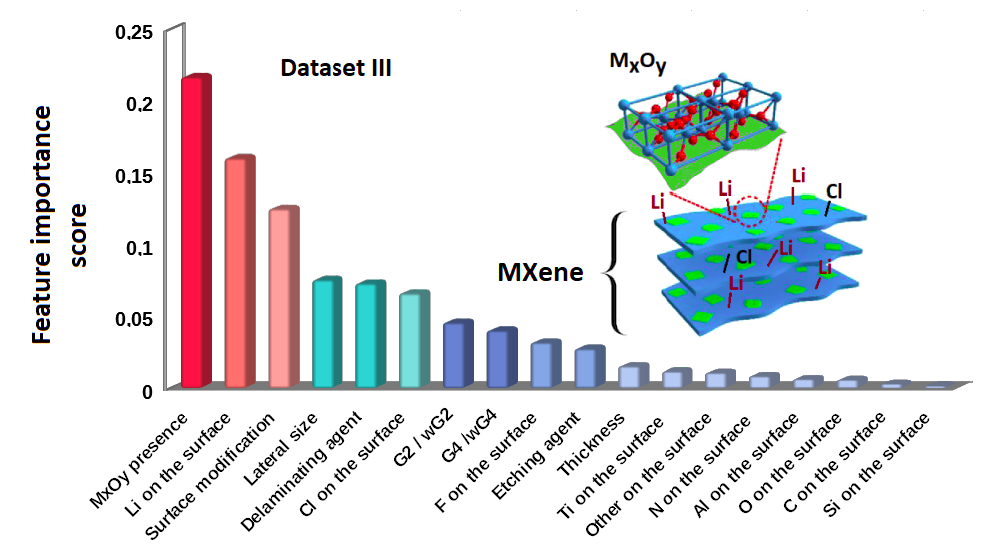
Figure 4. Ranking of feature importance for dataset III. The most important are the first three descriptors, namely M x O y , Li on the surface and surface modifications, respectively. All feature labels are described in Tables A2 and